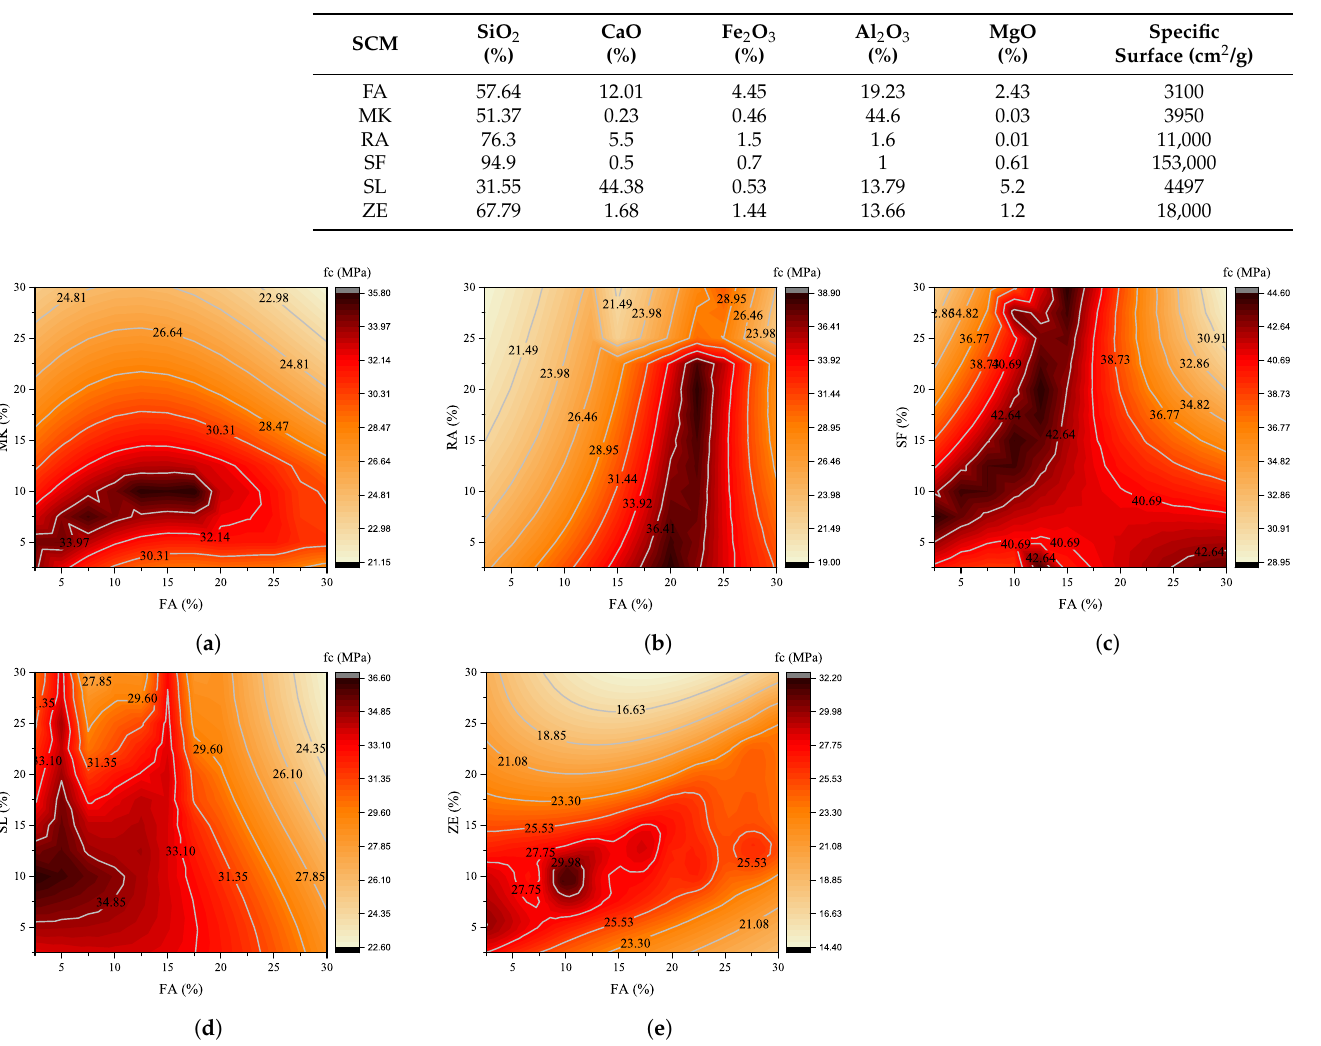
Table 10. The physical and chemical properties of SCMs used to generate new results.